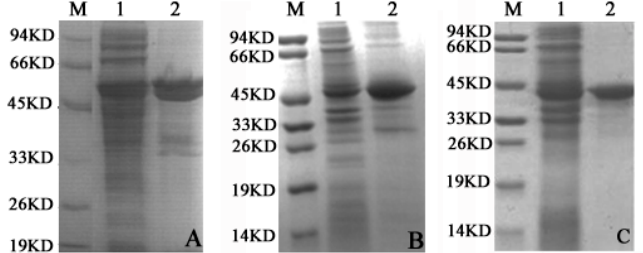
Figure 2. Analysis of the cell-free extracts recombinant protein by SDS-PAGE. ( A ) LDHA; ( B ) LDHB; and ( C ) LDHC. For ( A – C ) Lane 1 and Lane 2 represent the total protein of supernatant and precipitation, respectively, in the E. coli BL21 (DE3) cells; M: molecular weight standards. SDS-PAGE analysis indicates LDHA, LDHB and LDHC expression in supernatant and precipitate fractions.